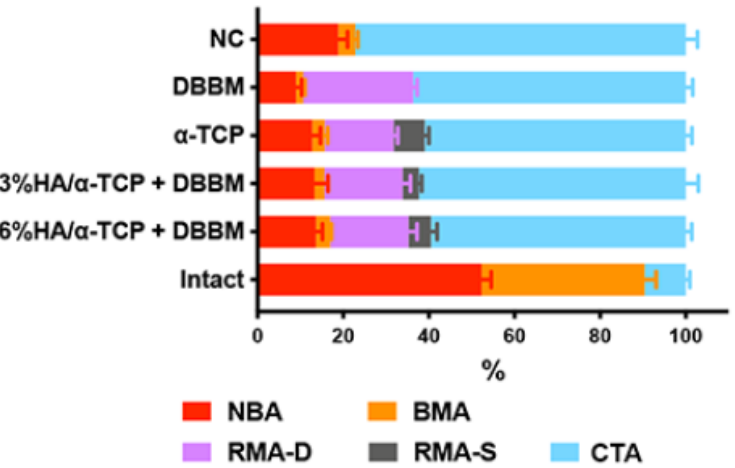
Figure 5. The summary of histomorphometry including NBA, BMA, RMA-D, RMA-S and CTA. The data of the intact calvarial bone without surgery is shown as a reference. The addition of the synthetic materials to DBBM increased the NBA to a level comparable to the NC group. Table 2. The histomorphometry in 10-mm defect ROI.